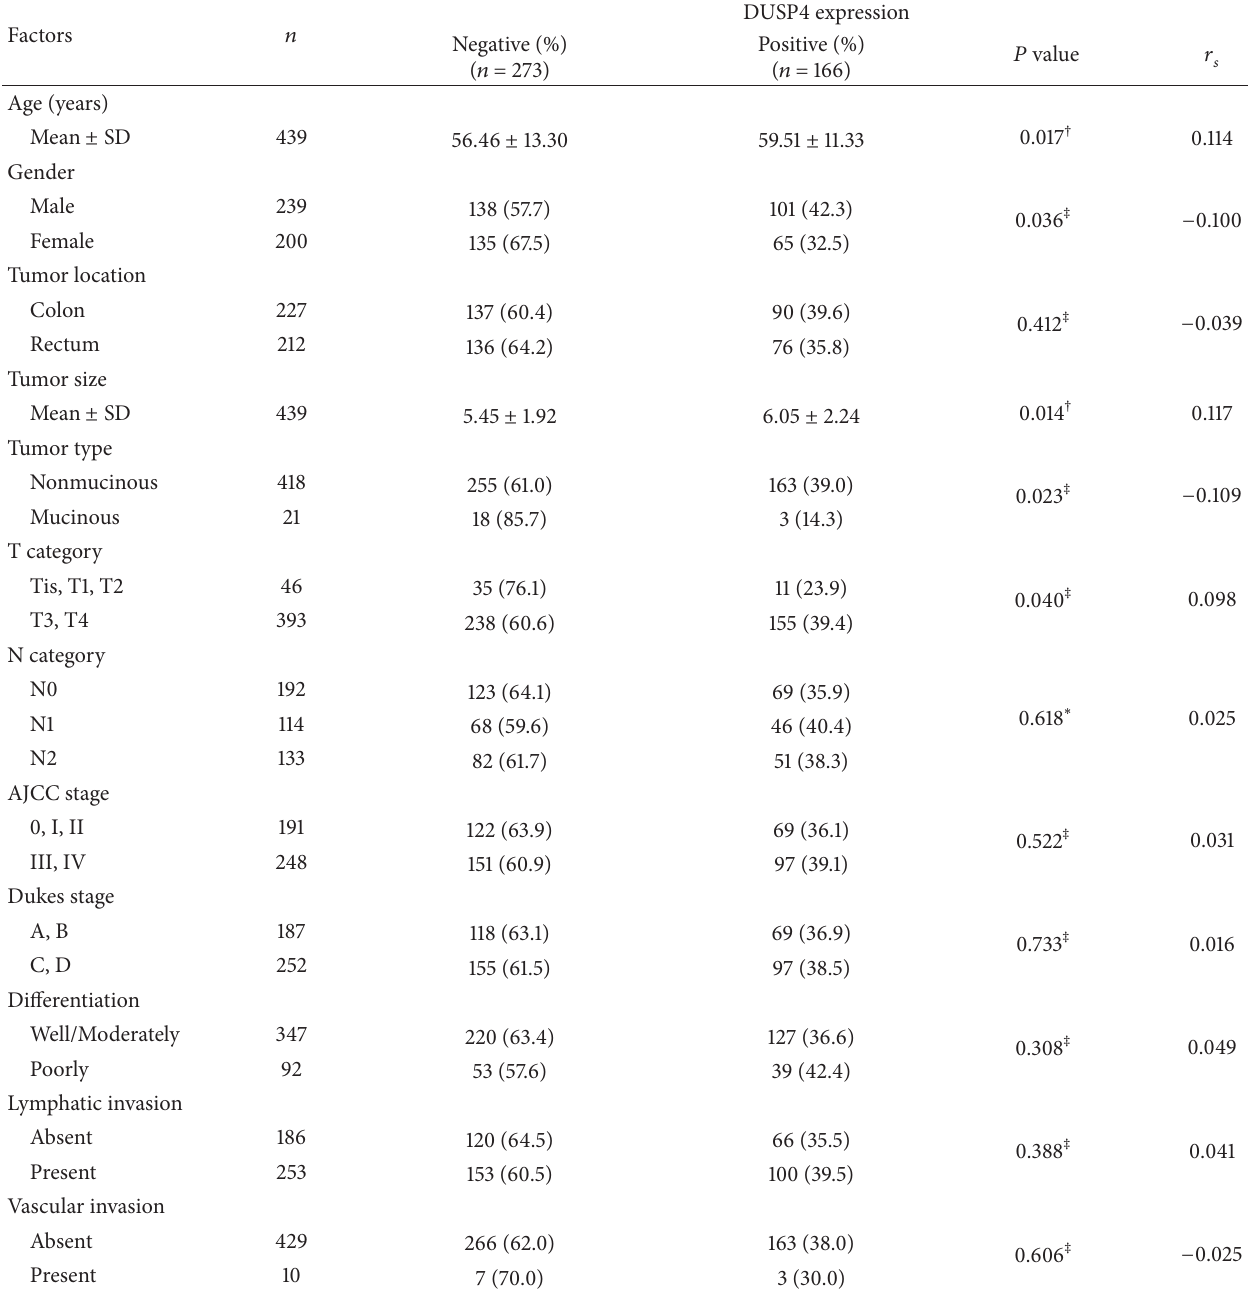
Table 2: Correlation between DUSP4 expression and clinicopathological factors in colorectal adenocarcinomas ( 𝑛 = 439).